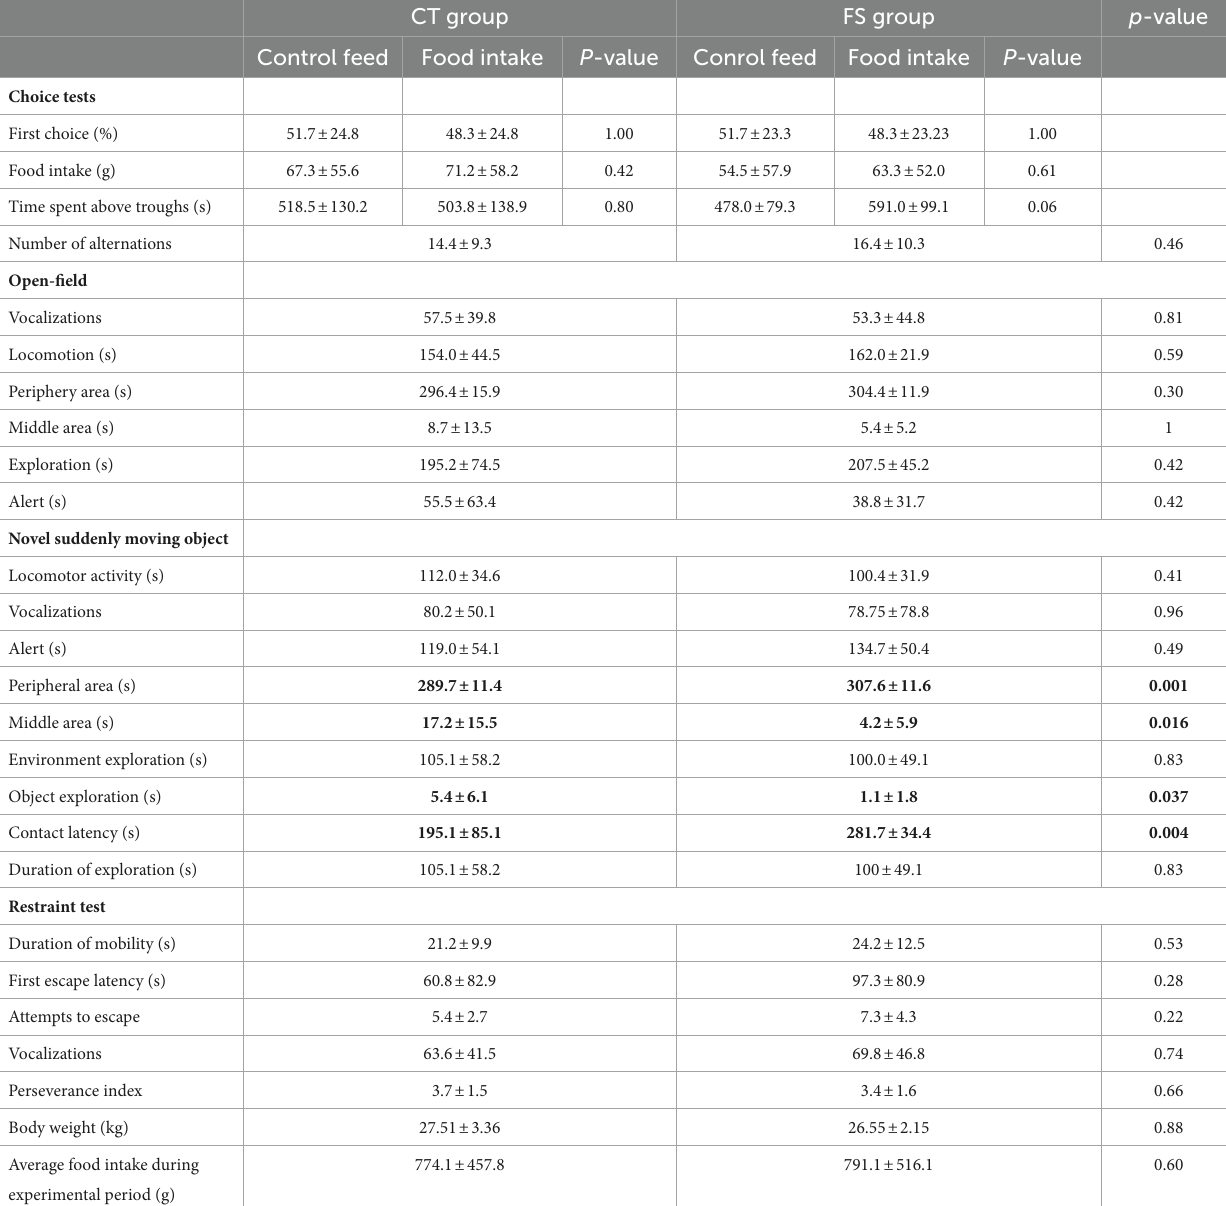
TABLE 1 Summary of behavioral outcomes for individuals in the control group (CT) and functional ingredient-supplemented group (FS). CT